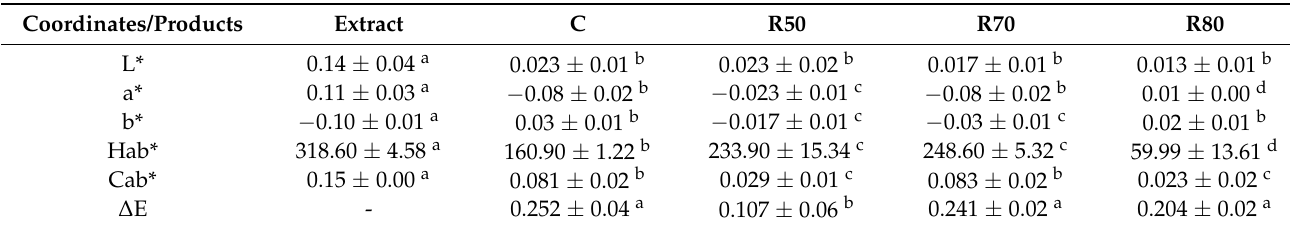
Table 3. Color in concentrated